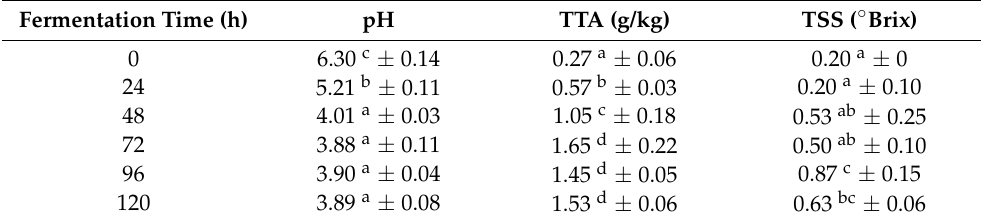
Table 1. pH, TTA, and TSS values of maize sourdough over different fermentation periods. Fermentation Time